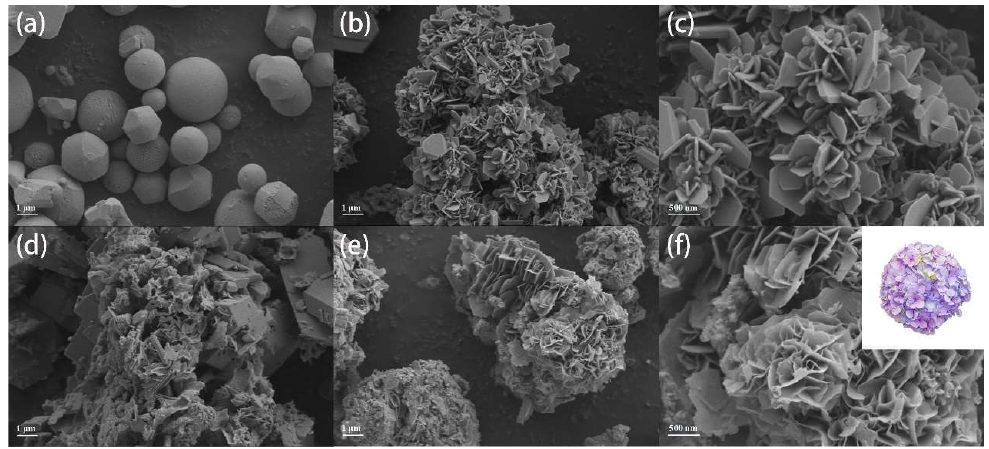
Figure 3. SEM images of ( a ) Bi 0 , ( b , c ) Bi 2 Se 3 , ( d ) Bi 2 O 3 , ( e , f ) 2BBOS.